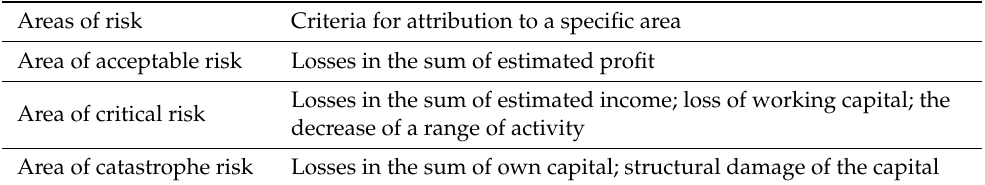
Table 1. Areas of risk, based on the results of business operations (the authors’ development). Areas of risk Criteria for attribution to a specific area Area of acceptable risk Losses in the sum of estimated profit Losses in the sum of estimated income; loss of working capital; the Area of critical risk decrease of a range of activity Area of catastrophe